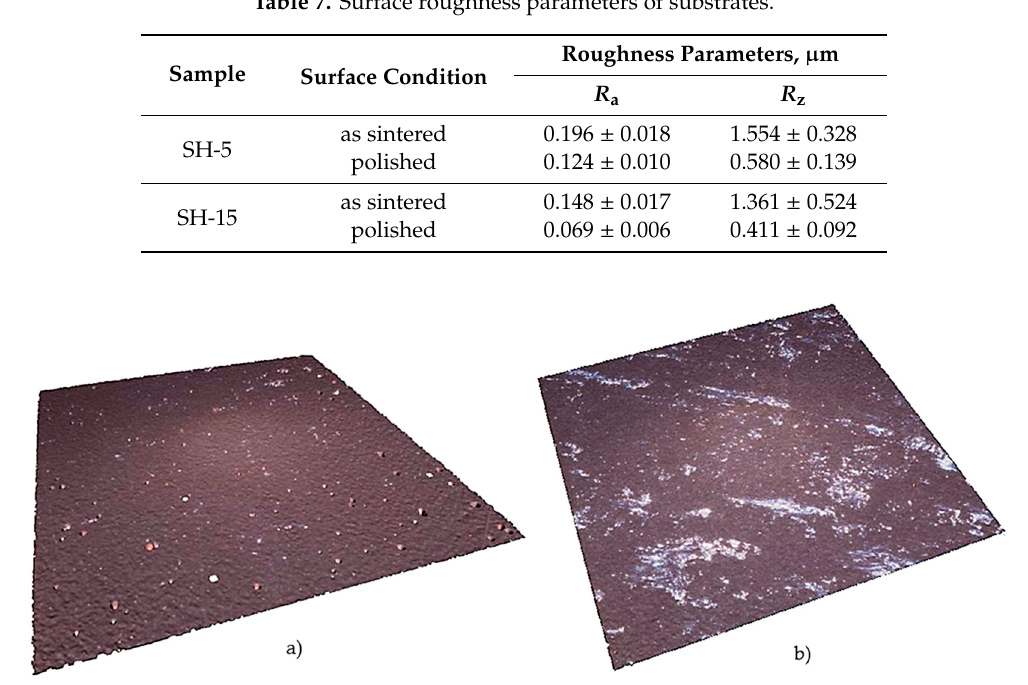
Table 7. Surface roughness parameters of substrates.